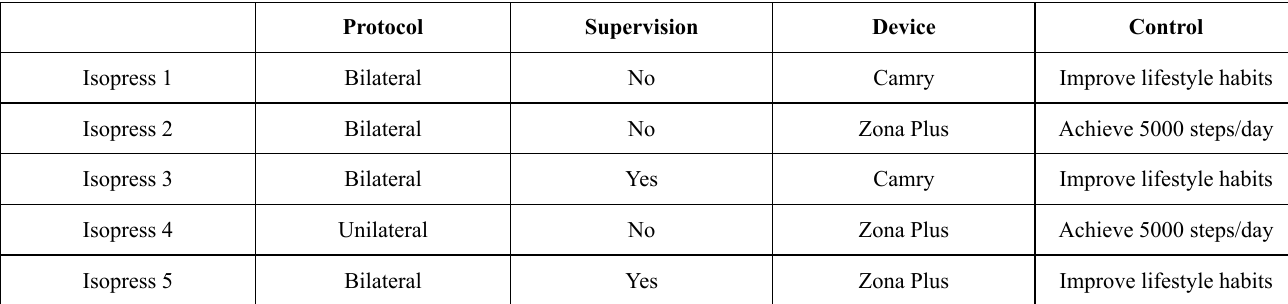
Table 2. Details of interventions between studies in the ISOPRESS